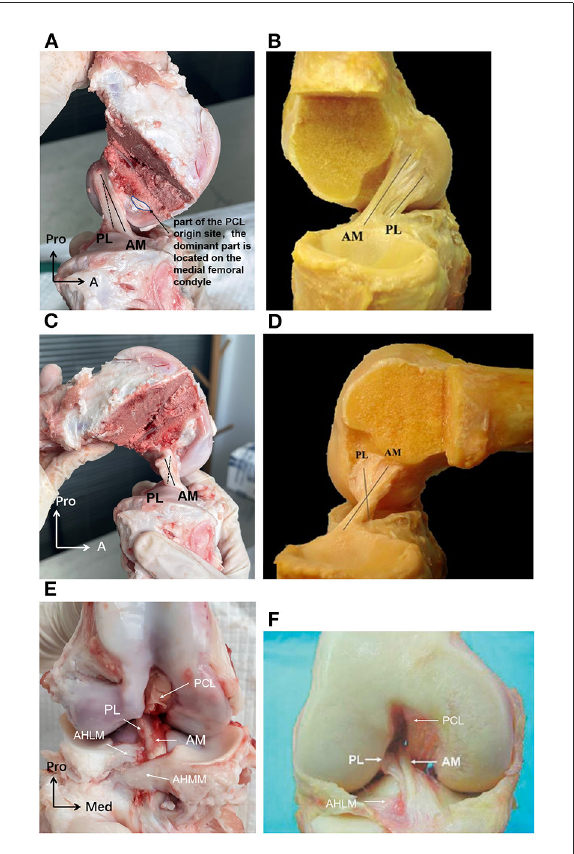
FIGURE5 (A) The porcine ACL at full knee extension in sagittal view. The AM bundle was lax while the PL bundle was tight, and the two bundles were almost parallel. (B) The human ACL at full knee extension in sagittal view. (C) The porcine ACL with knee flexed to around 90. The AM bundle was tight while the PL bundle was lax, and the two bundles formed an intersecting structure. (D) The human ACL with knee flexed to around 90. (E) The porcine ACL in the coronal plane. The AM bundle of the porcine ACL was anterior and medial to the PL bundle at the tibial insertion. The AHLM (anterior horn of the lateral meniscus) split the porcine ACL into AM and PL bundles. (F) The human ACL in the coronal plane. The AM bundle of the human ACL was